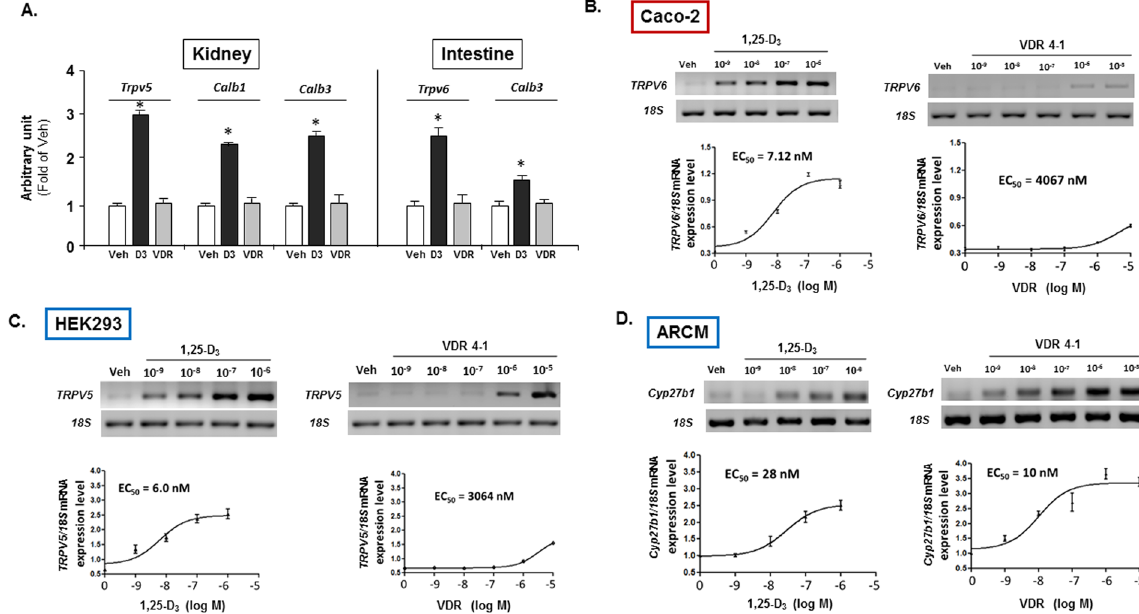
Figure 5. EC 50 of VDR 4-1 (VDR) compared to 1,25-D 3 (D3). ( A ) mRNA expression levels of various VDR- responsive genes in the kidney and intestinal tissues after VDR 4-1 administration (0.6 mg/kg). * p < 0.05 vs Veh; N = 3/group. ( B–D ) Representative PCR (upper panels) and EC 50 graphs (lower panels) of VDR responsive genes in Caco-2 intestinal ( B ) and HEK293 kidney ( C ) and ARCM cells ( D ). Only relevant PCR bands are shown. No alteration was done to the original gel images. TRPV6 , TRPV5 and Cyp27b1 are measured for Caco-2 intestinal ( B ) and HEK293 kidney ( C ) and ARCM cells ( D ), respectively. Calcitriol (left panels) and VDR 4-1 (right